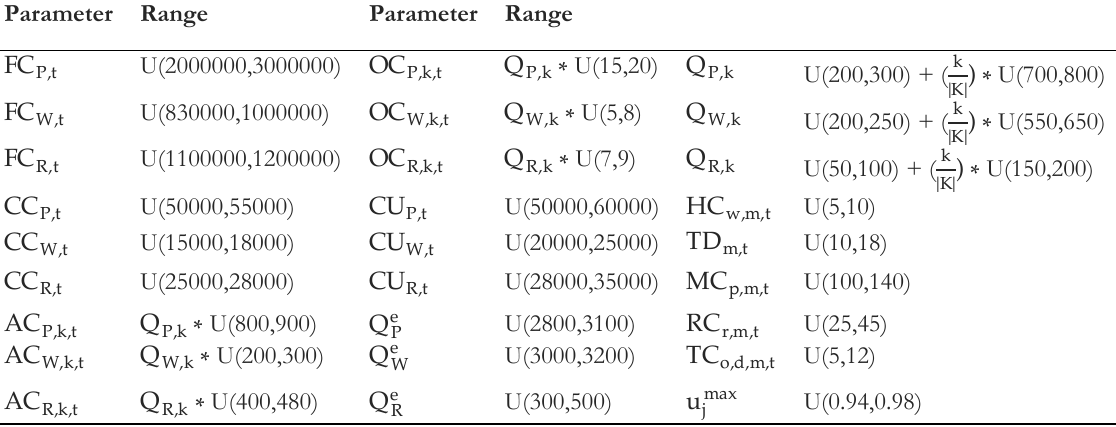
Table 6. Parameters used in the small test instance.